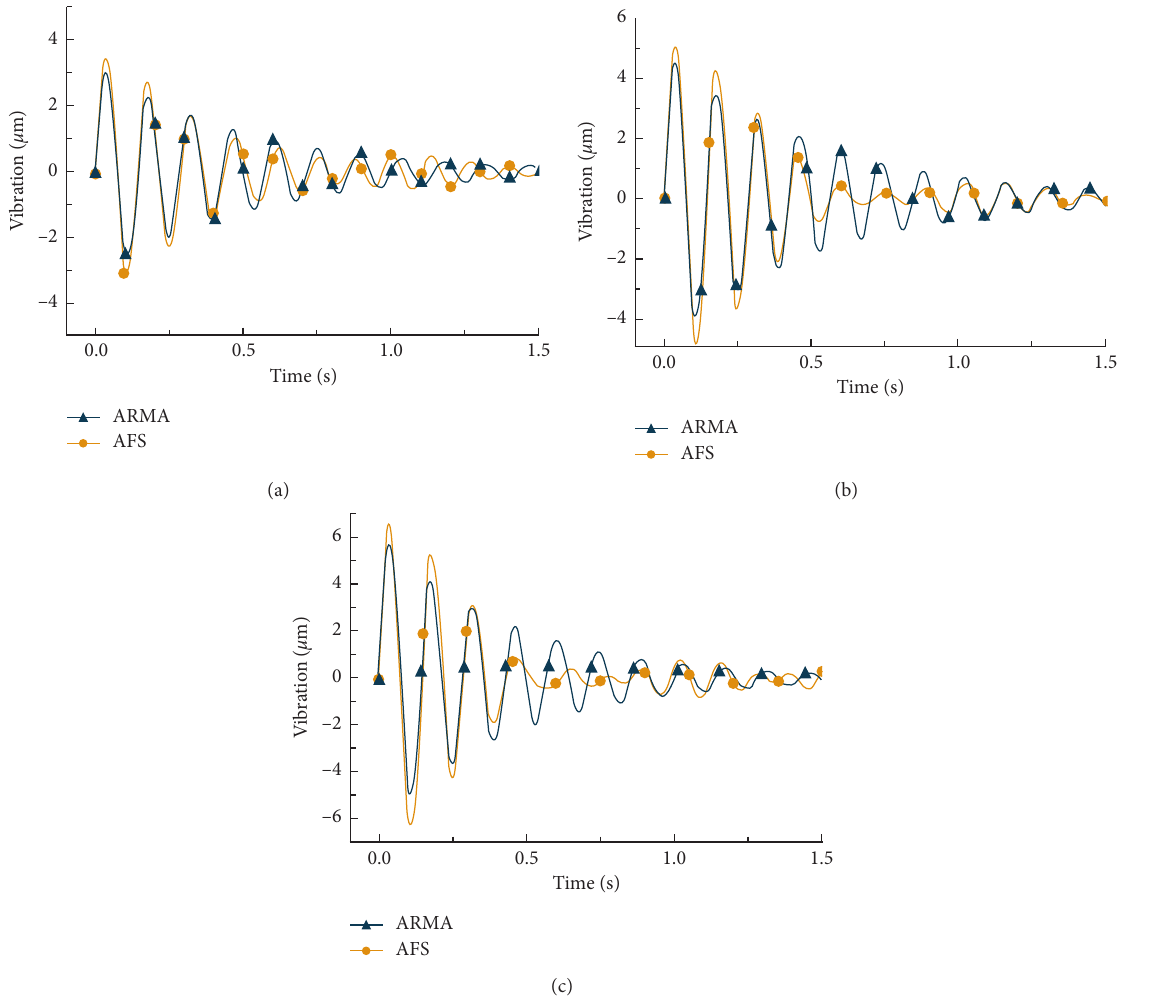
� 0.3m s − 1 and different a − . (a) a − � 2g; (b) a − � 2.5g; (c) max